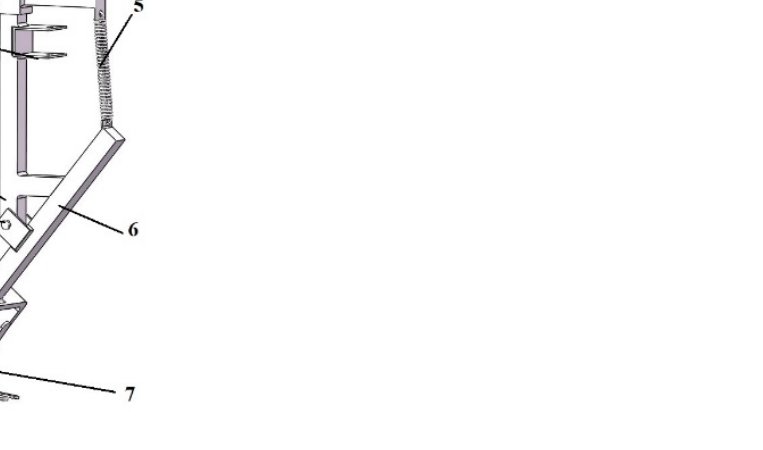
Figure 2. Structure diagram of weeding wheel. 1. Roller 2. Bolted connection point 3. Support bar 4. Soleplate 5. Spring 6. Connecting rod 7. Rake weeding